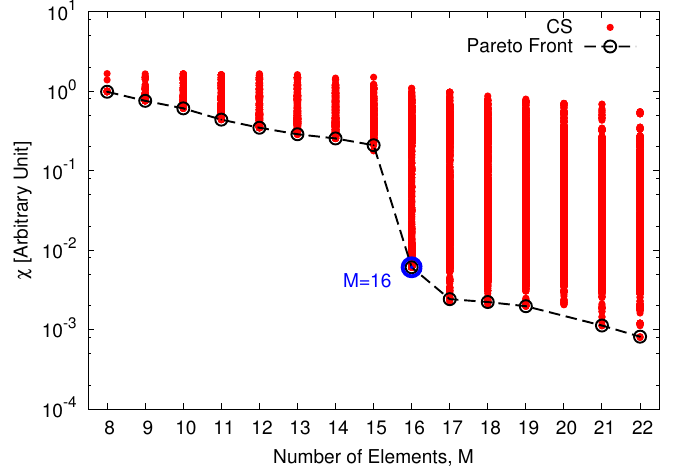
Figure 6. Numerical Assessment ( I = 22, d = λ the CS-synthesized plank layouts and the corresponding Pareto front.